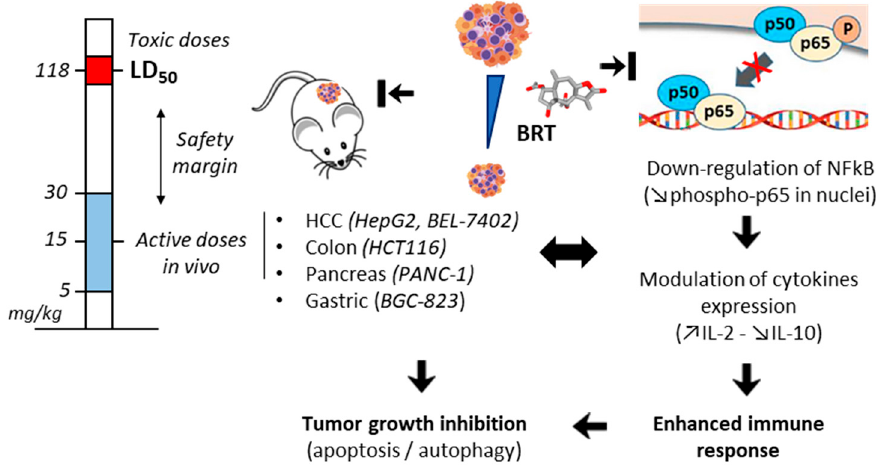
Figure 4. Anticancer activity of BRT in xenograft mice models of solid tumors. The compound was found to reduce tumor growth when administered (intraperitoneally) at the dose of 5–30 mg/kg (active doses), well inferior to the toxic dose (LD 50 ) determined in an acute toxicity study (derived from [65]). The contribution of NF κ B inhibition and immune regulation to the anticancer action of BRT is highlighted. Inhibition of p65 nuclear expression and up-regulation of interleukin-2 (IL-2) coupled to down-regulation of IL-10 expression have been evidenced in BGC-823 gastric tumors [66]. BRT-induced immune response plays a marked role in the antitumor action.